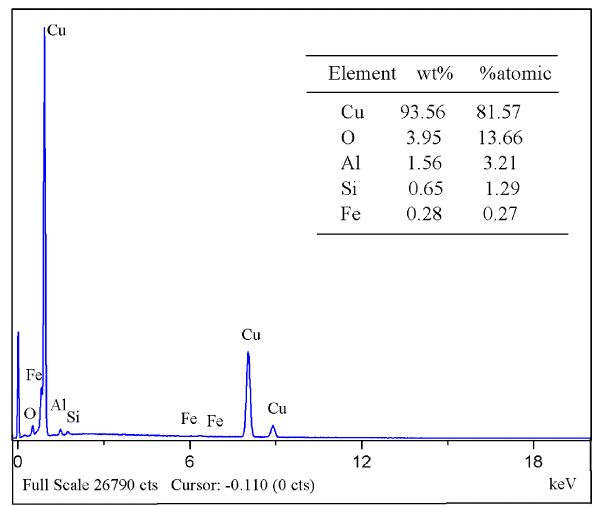
Figure 12. Energy dispersive X-ray (EDX) analysis of the sintered sample with heating rate (3 °C/min), highest temperature (1083 °C), and holding time (3 h).